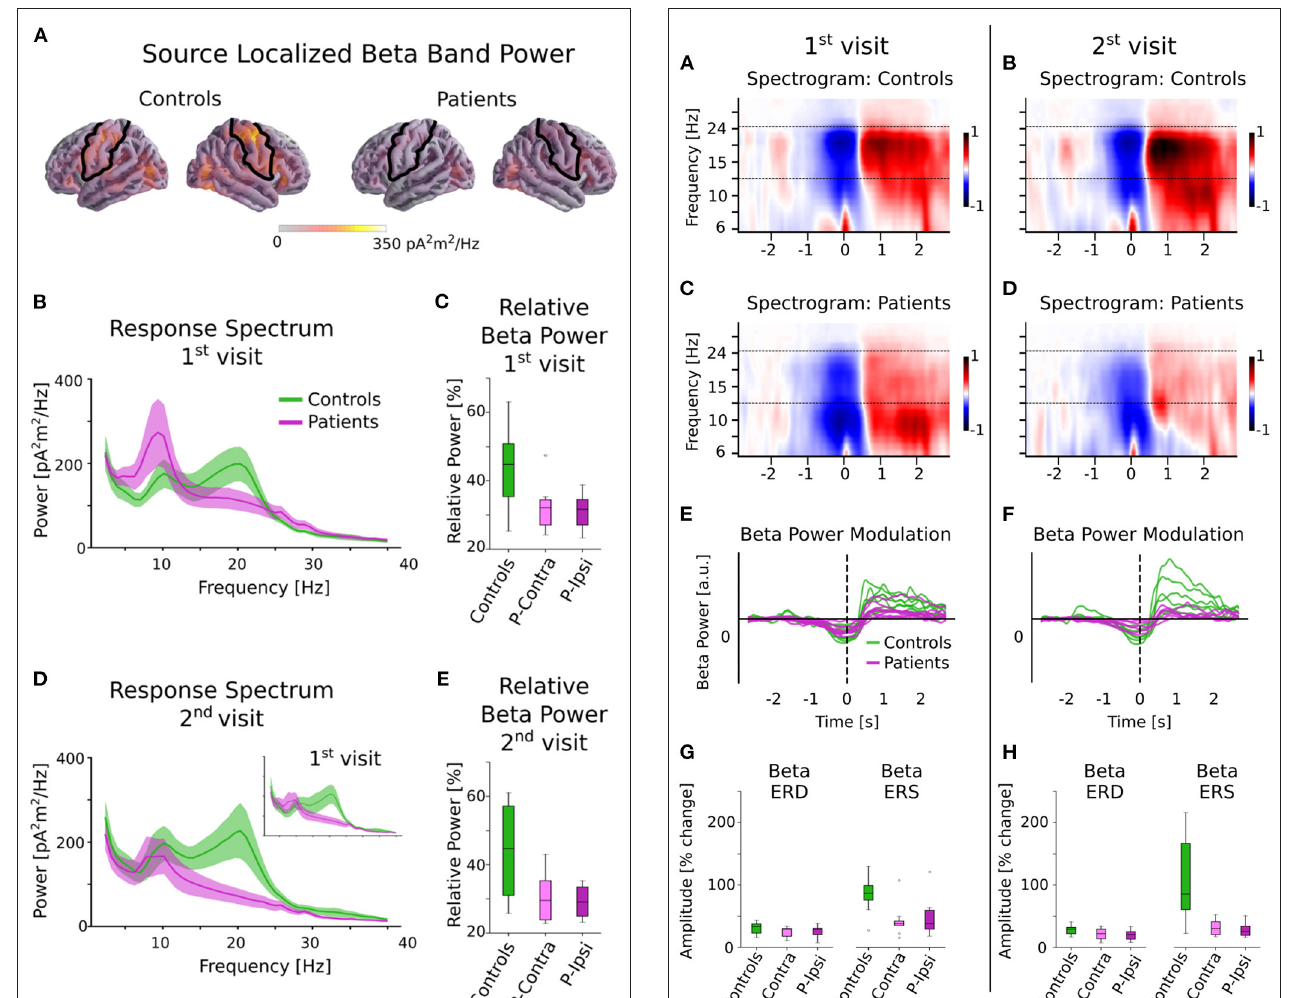
without prior history of stroke were recruited for this study.